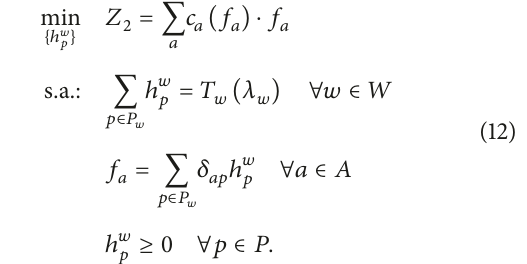
Figure 2: Relationship between the price of anarchy (𝜙) and the demand level (𝑇) in a road